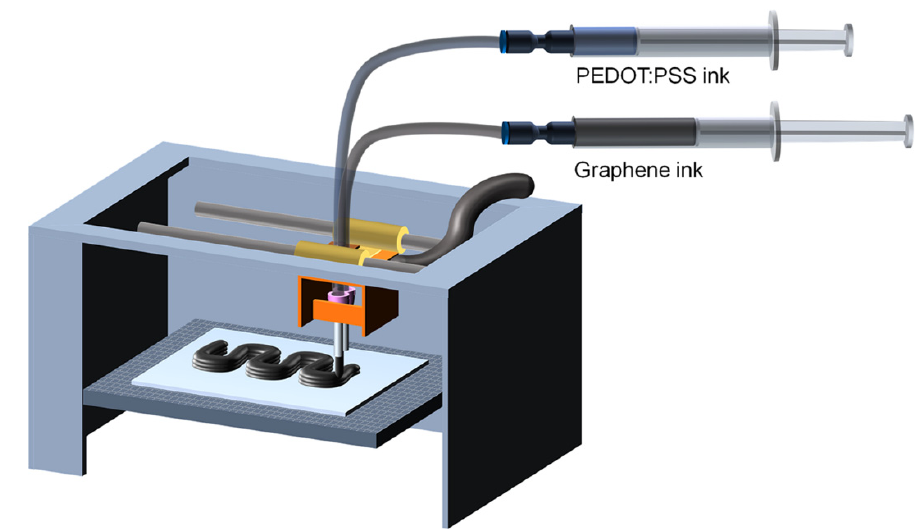
Figure 1. Schematic illustration of the consecutive ink writing with PEDOT:PSS and graphene inks.